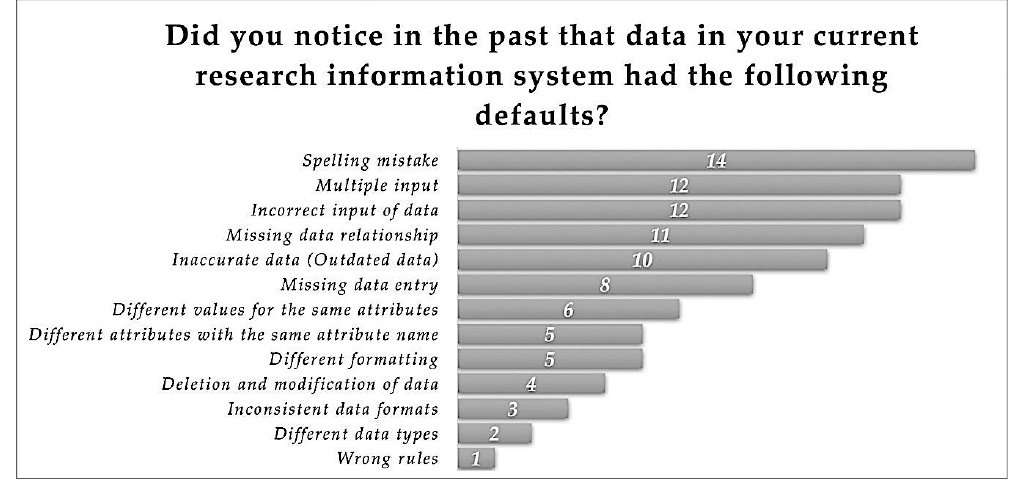
Figure 3. Data quality issues in CRIS ( N = 17 ).